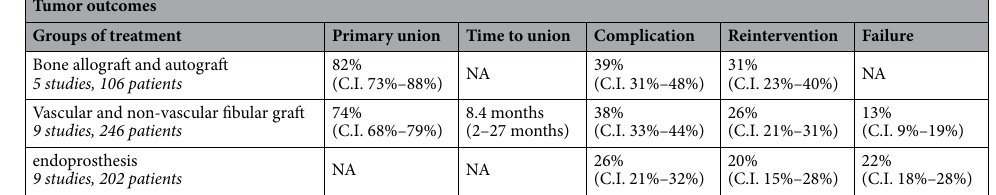
Table 5. Summary of tumor studies outcomes.